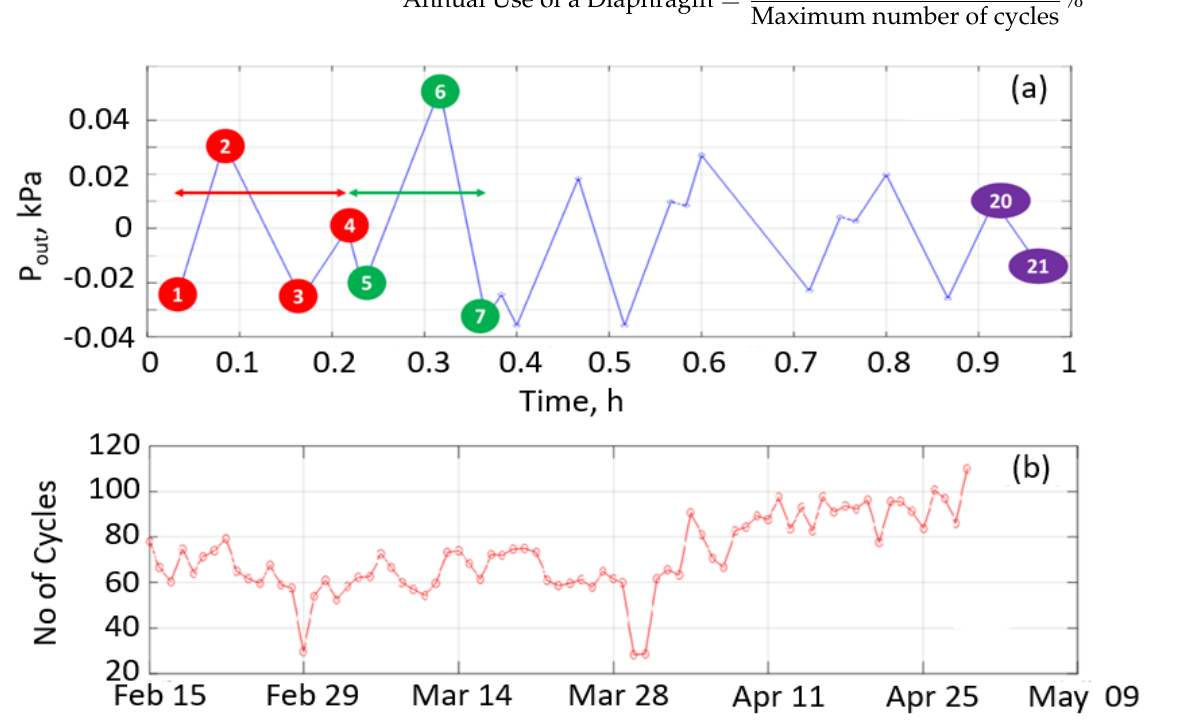
Figure 6. ( a ) The number of cycles in one hour (1, 2, . . . 21 are the local minimum and maximum values) and ( b ) the daily number of cycles.